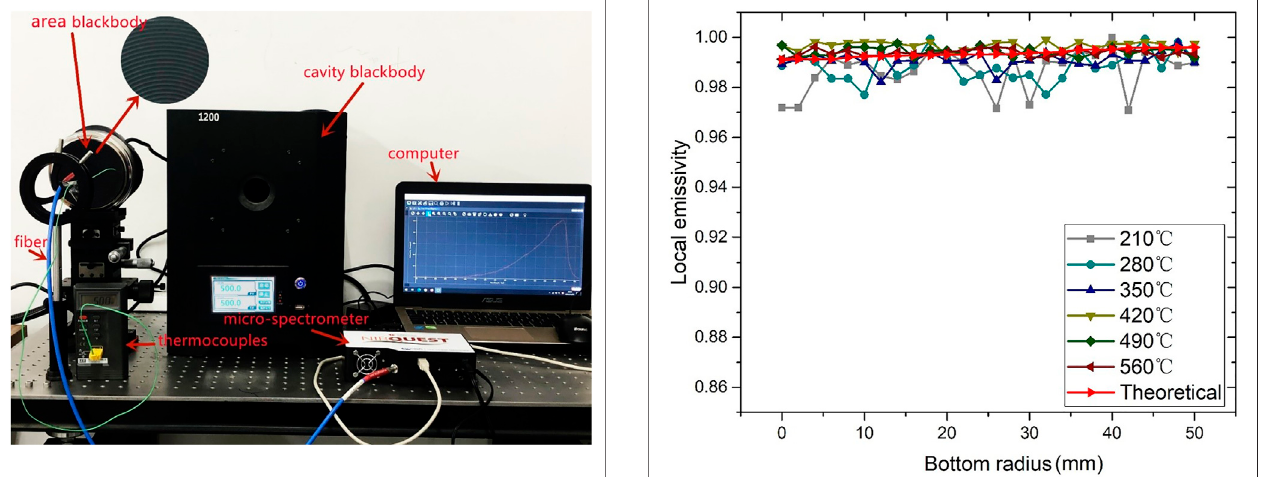
FIGURE7| Experimentalscenario(measuredcavityblackbodyandarea blackbody radiation intensity with wavelength at the same temperature).